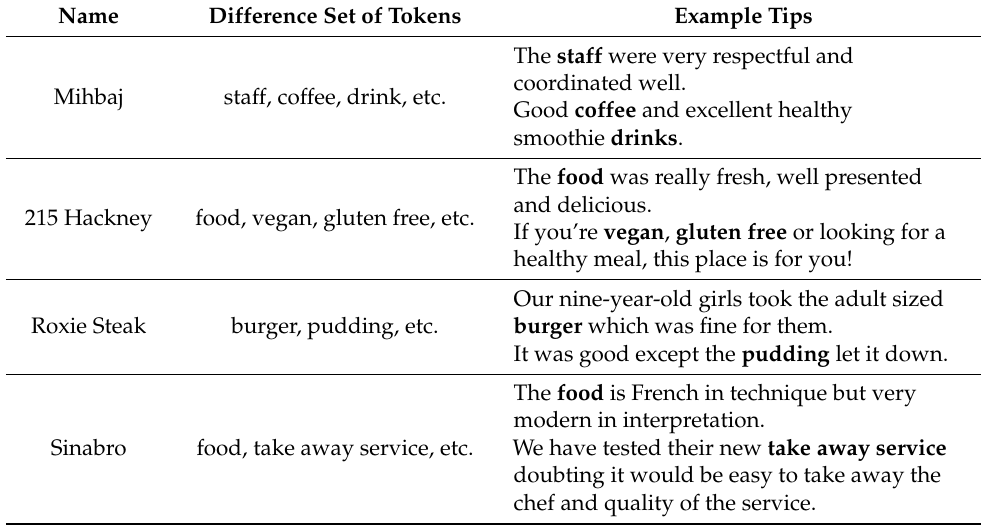
Table 8. Examples of tokens in the difference sets and